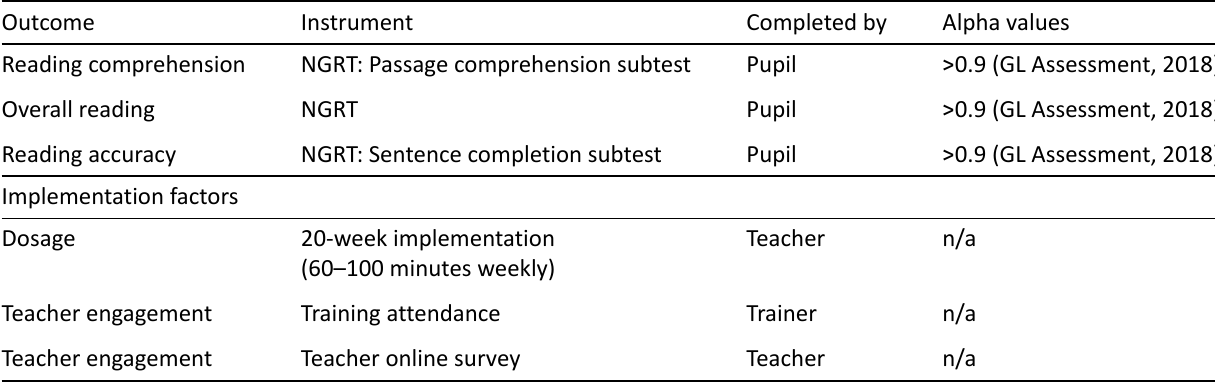
Table 1. Measurement